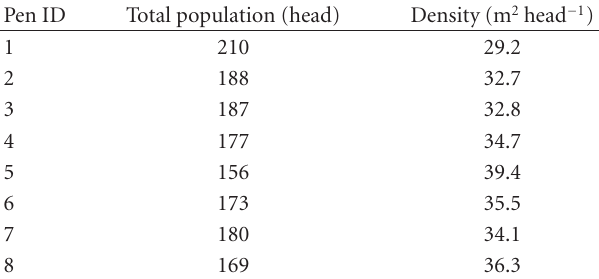
Table 1: Average animal population and density for each pen dur- ing the summer